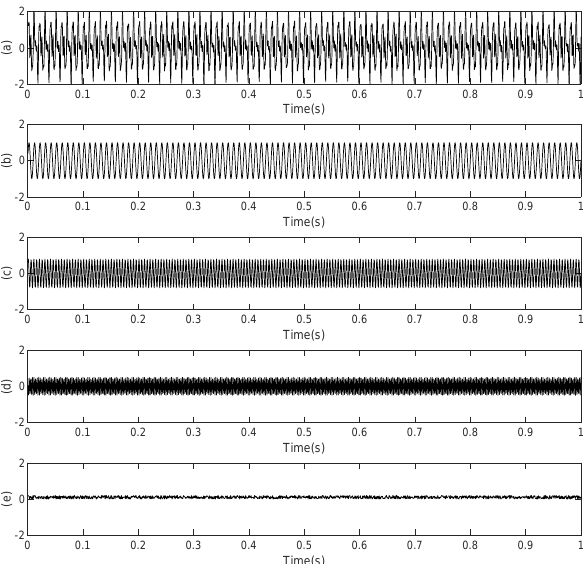
Figure 2. The mixed signal and its components. ( a ) Mixed signal; ( b – e ) basic signal 1–4. Set [ K , α ] = [4, 1000], and use the VMD method to decompose the mixed signal. The results are shown in Figure 3. The four components obtained through decomposition can be associated with the basic signals 1 to 4 that constitute the mixed signal, and their waveforms show a high level of consistency. The IMF1 component decomposed from the mixed signal is signal 1, the IMF2 component is signal 3, the IMF3 component is signal 2, and the IMF4 component is signal 4. However, the higher the signal frequency, the more pronounced the envelope of IMF is affected by noise, such as IMF2. It indicates that the noise is not entirely separated from the mixed signal, which is not conducive to displaying ice layer details. The noise interference can be reduced by changing the quadratic penalty factor α . In addition, the radar receives different echo signals in detecting the glacier, including the reflection of objects on the ground, the reflection of the ice surface, the reflection of the interface of the inner ice layer, etc. The number of modes K cannot be determined directly. The decomposition may be incomplete when K is less than the number of basic signals. For example, set the parameters [ K , α ] = [2, 1000], and again use the VMD method to decompose the mixed signal, and the result is shown in Figure 4. The result shows that the change in the K value will directly affect the decomposition accuracy, and an inappropriate K value will reduce the performance of the VMD method.